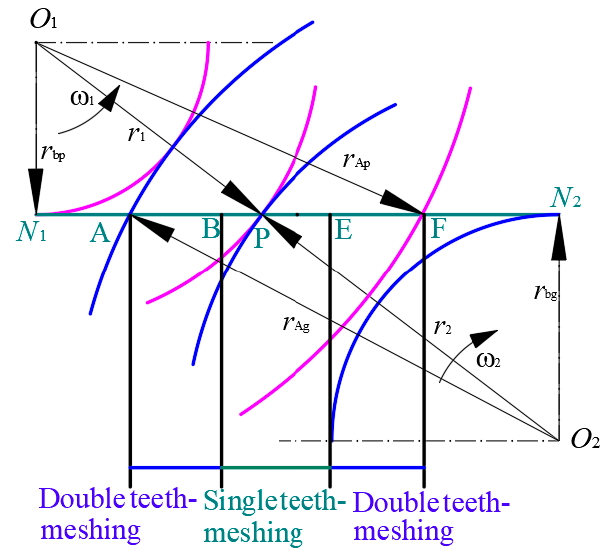
Figure 5. Simplified model of spur gear.